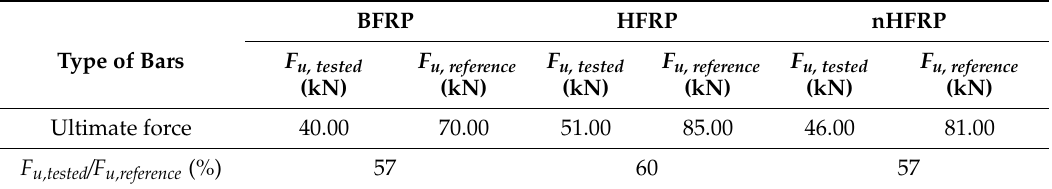
Table 4. Mechanical properties of the FRP bars utilized in the